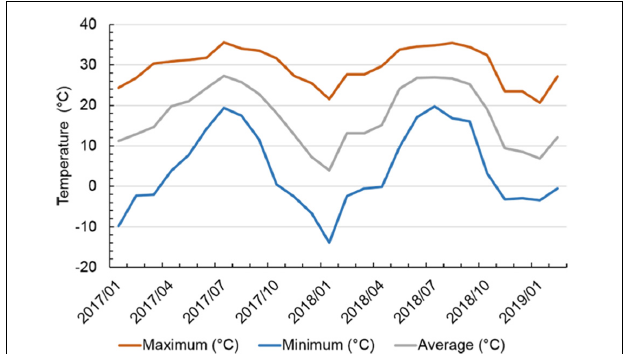
FIGURE 1 | Maximum, minimum, and average air temperatures on a monthly basis in Starkville, MS, United States from January 2017 to February 2019. Air temperature data were obtained from the website of USDA Natural Resources Conservation Service